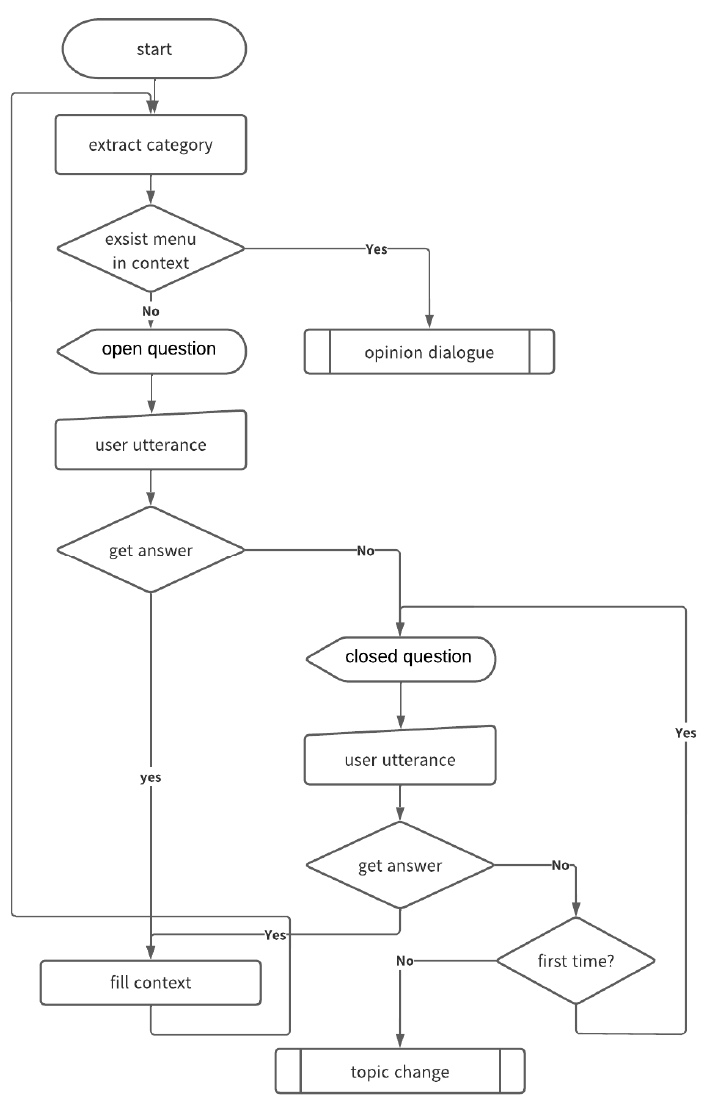
Figure 4. Dialogue system flowchart.